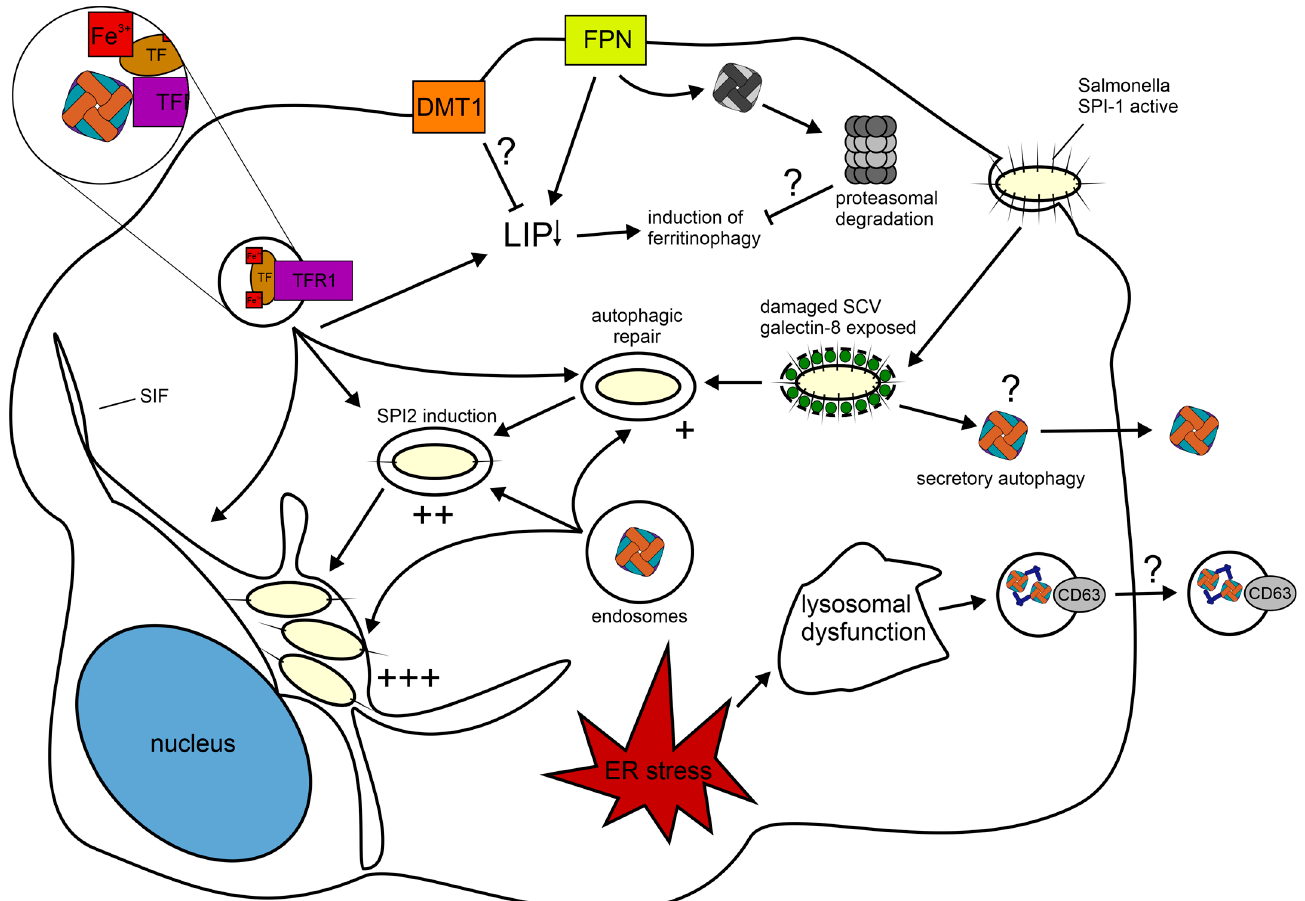
Figure 3. Schematic depiction of possible S .Tm or host-derived mechanisms regarding ferritin during infection. The graphic illustrates the path of the establishment of the intracellular replication niche of S .Tm. For simplicity, the vacuolar escape of S .Tm is not depicted, but it is necessary to mention that cytosolic S .Tm might use iron from ferritin-NCOA4 liquid-phase condensates. However, the entry of S .Tm via its SPI-1 encoded T3SS results in membrane damage of the SCV, which might trigger secretory autophagy of ferritin. Subsequently, S .Tm repairs this damage via the host autophagy machinery. Inside the SCV, S .Tm is able to acquire endosomal cargo, which likely includes ferritin. The access to endosomal cargo is enhanced by SPI-2 and even further upon the formation of SIF. The ability of the differently maturated SCV to acquire endosomal cargo is marked with increasing plus signs adjacent to the respective SCV. Furthermore, this endosome hijacking by S .Tm might result in reduced intracellular iron levels by inhibiting uptake of extracellular iron, which would consequently trigger ferritinophagy to satisfy the host’s iron demand. A possible host defense strategy against this might be direct uptake of iron via DMT1. Additionally, FPN might mobilize ferritin-bound iron, which may result in the ensuing proteasomal degradation of iron-poor ferritin in the cytosol. Another host defense strategy might also be a shift of ferritin to the extracellular compartment via the secretion of ferritin-containing exosomes. Thereby, S .Tm induced ER stress, which in turn results in lysosomal dysfunction and the subsequent release of CD63-positive exosomes, which might also contain ferritin. The SPI-1 and SPI-2 encoded T3SS are depicted as spikes on S .Tm. Hitherto unknown or unresolved mechanisms are highlighted with a question mark. SPI-1/2: Salmonella pathogenicity island, T3SS: type 3 secretion system, SCV: Salmonella-containing vacuole, TFR1: Transferrin